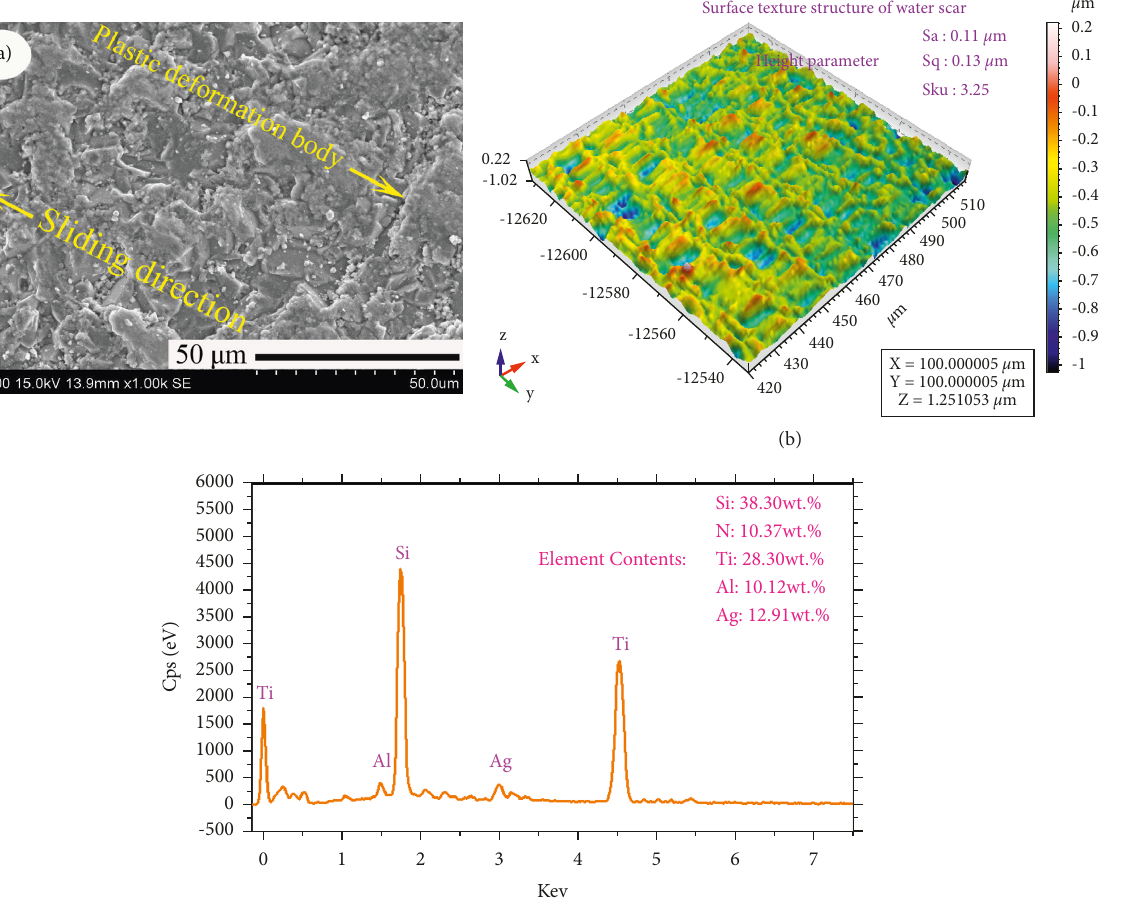
Figure 10: Typical FESEM morphology (a), texture structure (b), and main element contents (c) of the wear scar of the fixed Si 90min.